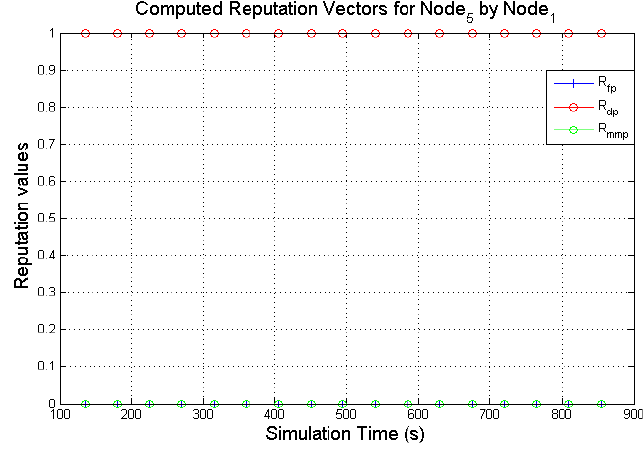
Figure 10. Reputation values for grey-hole node ( N 8 ) calculated by good node ( N 7 ).